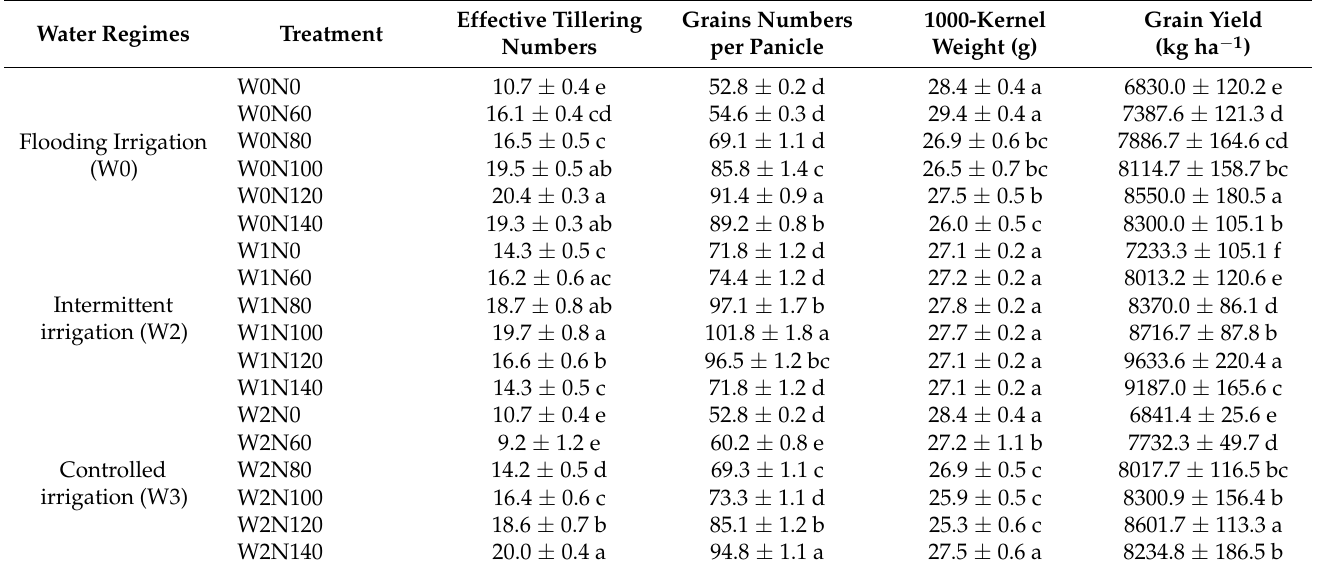
Table 1. Effective tillering numbers, grain numbers per spike, 1000-kernel weight, and grain yield induced by water irrigation regime and N fertilization over the rice-growing season.